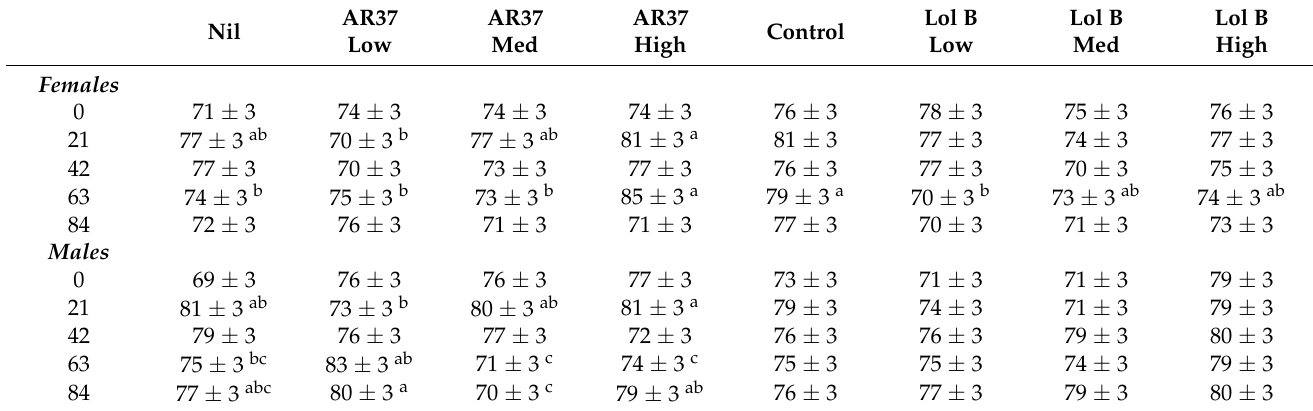
Values are means ± standard error ( n = 10). Fisher’s least significant difference was used to compare treatment means. Two means that have no letter in common are statistically different at the 5% level. If no letters are present, no statistical difference was found between the groups. Table 4. Diastolic blood pressure (mm/Hg) of mice fed a diet containing lolitrem B (0, 0.265, 0.53 or 1.06 ppm for control, low, med and high, respectively) or AR37 endophyte-infected seed diet (0, 7.5, 15 or 30% for nil, low, med and high,